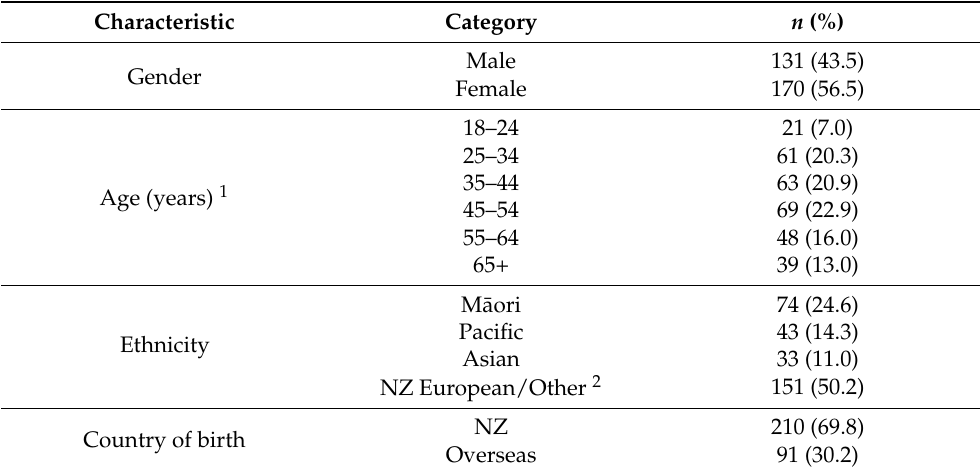
Table 1. Participant demographic characteristics at baseline.